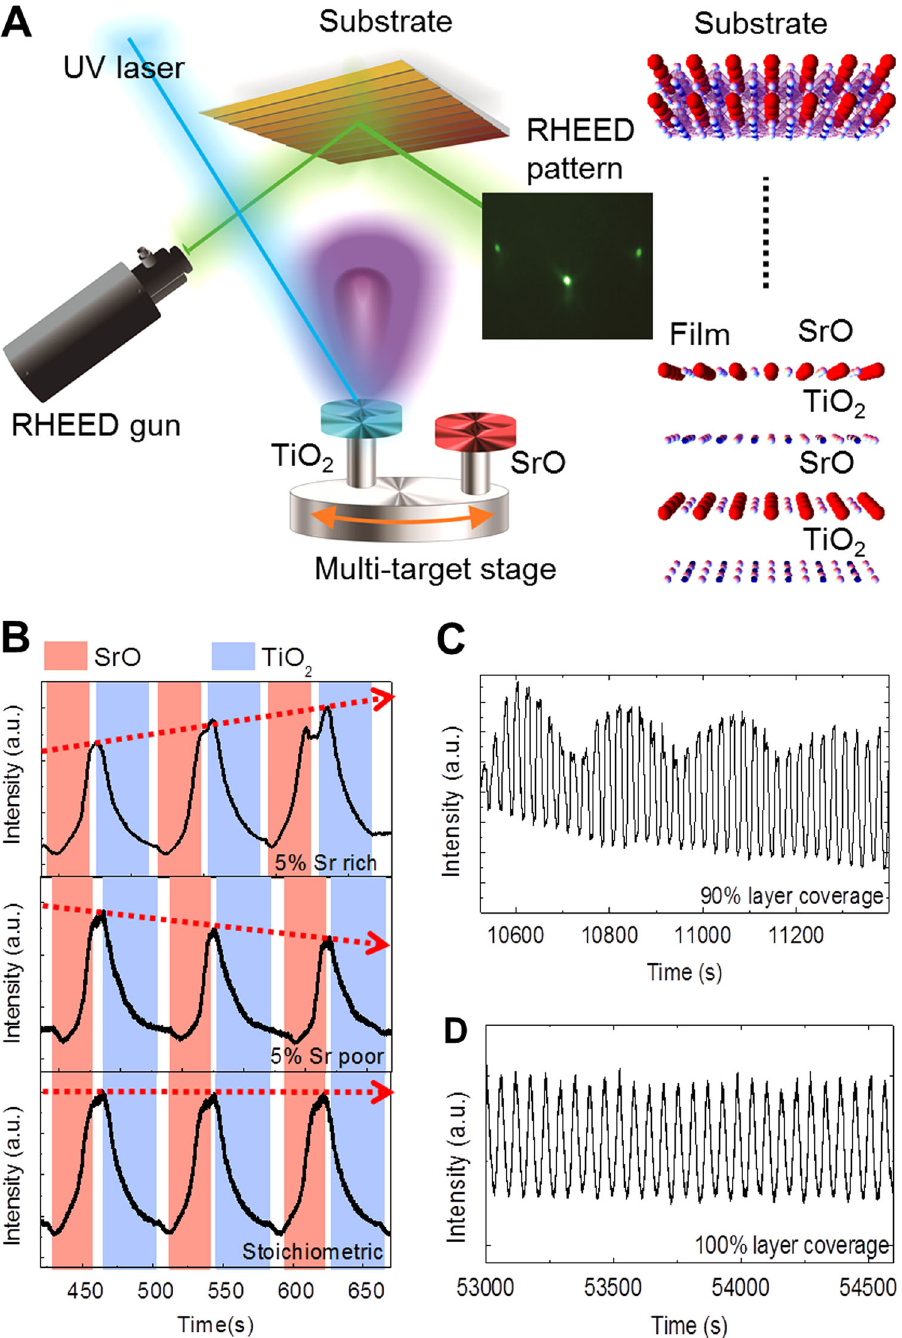
oscillations during the atomic layer-by-layer growth of SrTiO 3 fi lms. The red and blue shaded areas represent the depositions of SrO and TiO 2 layers, respectively. The white areas represent target switching when no ablation takes place. The red dotted lines indicate variations of the intensity for the cases of Sr-rich, Sr-poor, and stoichiometric deposition, respectively. c RHEED intensity beating when 0.9 monolayers of SrO and TiO 2 are deposited during each target switching cycle. d Characteristic RHEED intensity oscillations during the growth of a stoichiometric SrTiO 3 sample with full layer